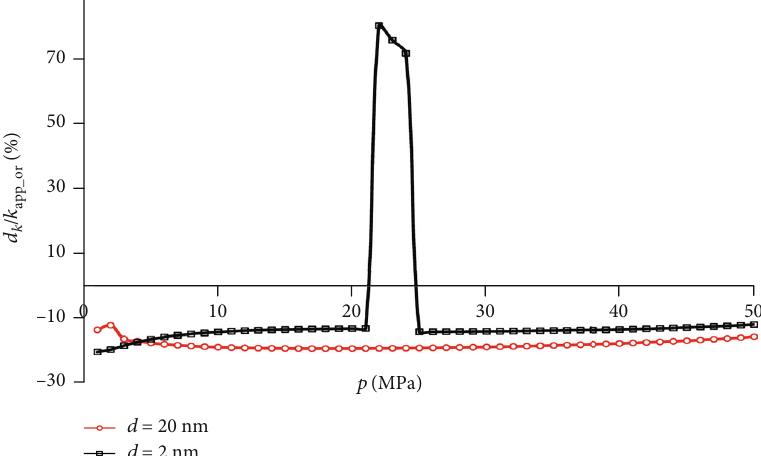
Figure 6: Curves of the ratio of change in the AGP to the AGP in the organic pore without considering the stress dependence.